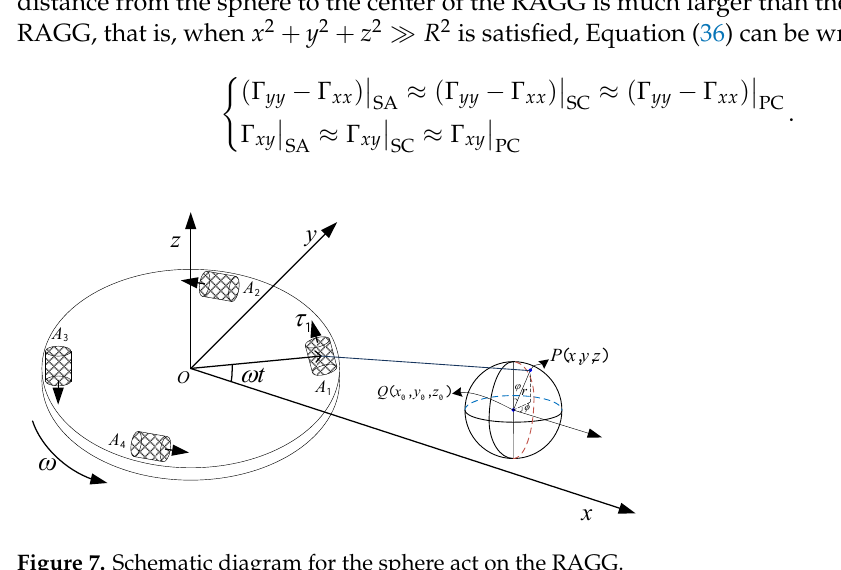
Figure 7. Schematic diagram for the sphere act on the RAGG. From Equation (34), Equation (36), we can get that the gravity gradient calculated by Equation (36) is more accurate than Equation (34) when the center of environmental mass is close to the center of the RAGG. In order to compare the difference between the two models intuitively, we simulate the two models. Assuming that y 0 = 0.1 m, z 0 = 0 m, R = 0.1 m, ω = 0.5 π rad/s, ρ = 18, 000 kg/m 3 , M = 486 kg (the wight of the sphere), (cid:112) R 0 = 3 3 M / ( 4 ρπ ) . When the sphere moves along the x -axis, the simulation results of the two models are shown in Figure 8. The blue solid line and the red dashed line in Figure 8a indicates the real gravity-gradient of RAGG calculated by Equation (36) and center gravity-gradient calculated by Equation (34), respectively. The results calculated by the two models are not equal, mainly because of the distance from the accelerometer to the center of the RAGG. Figure 8b indicates that the calculation error between the two models. From Figure 8b, as the distance between the sphere and the center of the RAGG decreases, the error between the two models becomes larger and larger. When the distance is close to 0.3 m, the calculation error between the two models exceeds 60